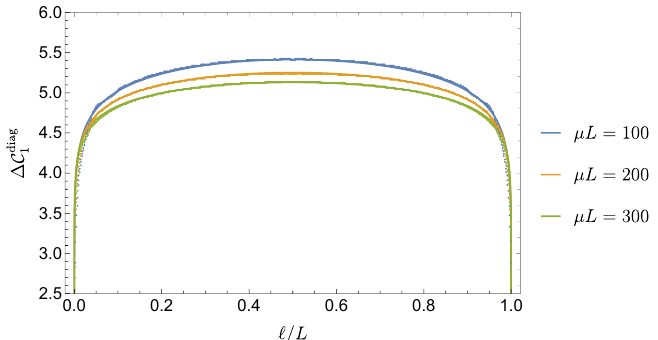
Figure 24 . Fits (solid curves) and data (points) of the size dependence of the mutual complexity in the diagonal basis (cid:1) C diag